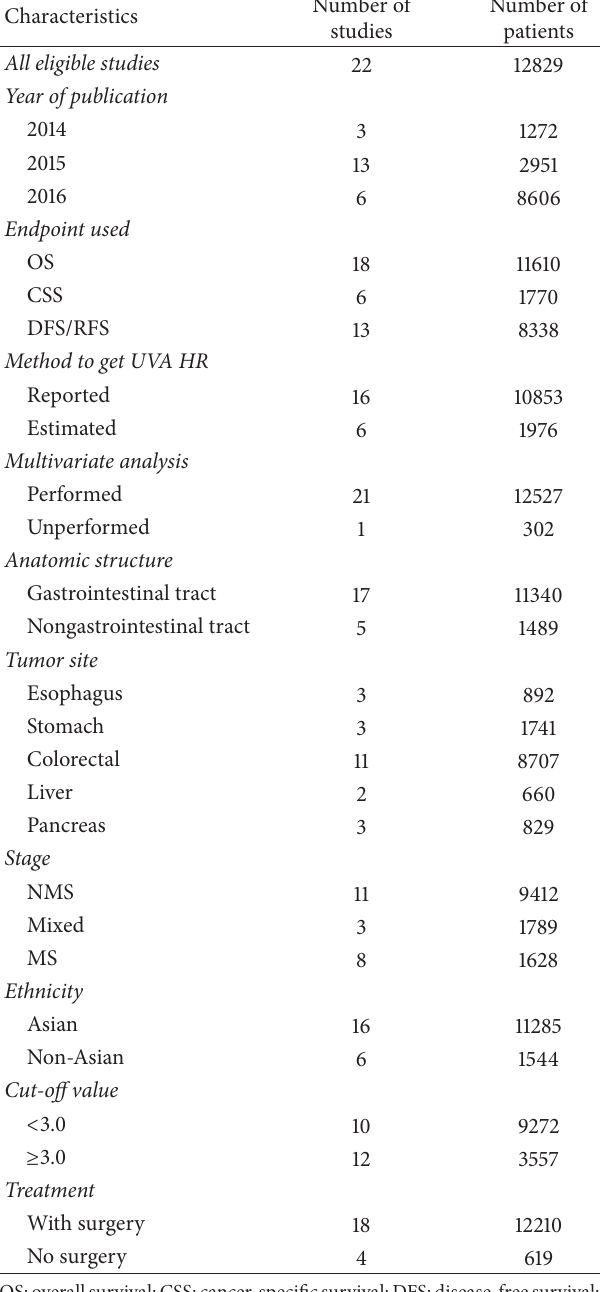
Table 1: Main characteristics of eligible